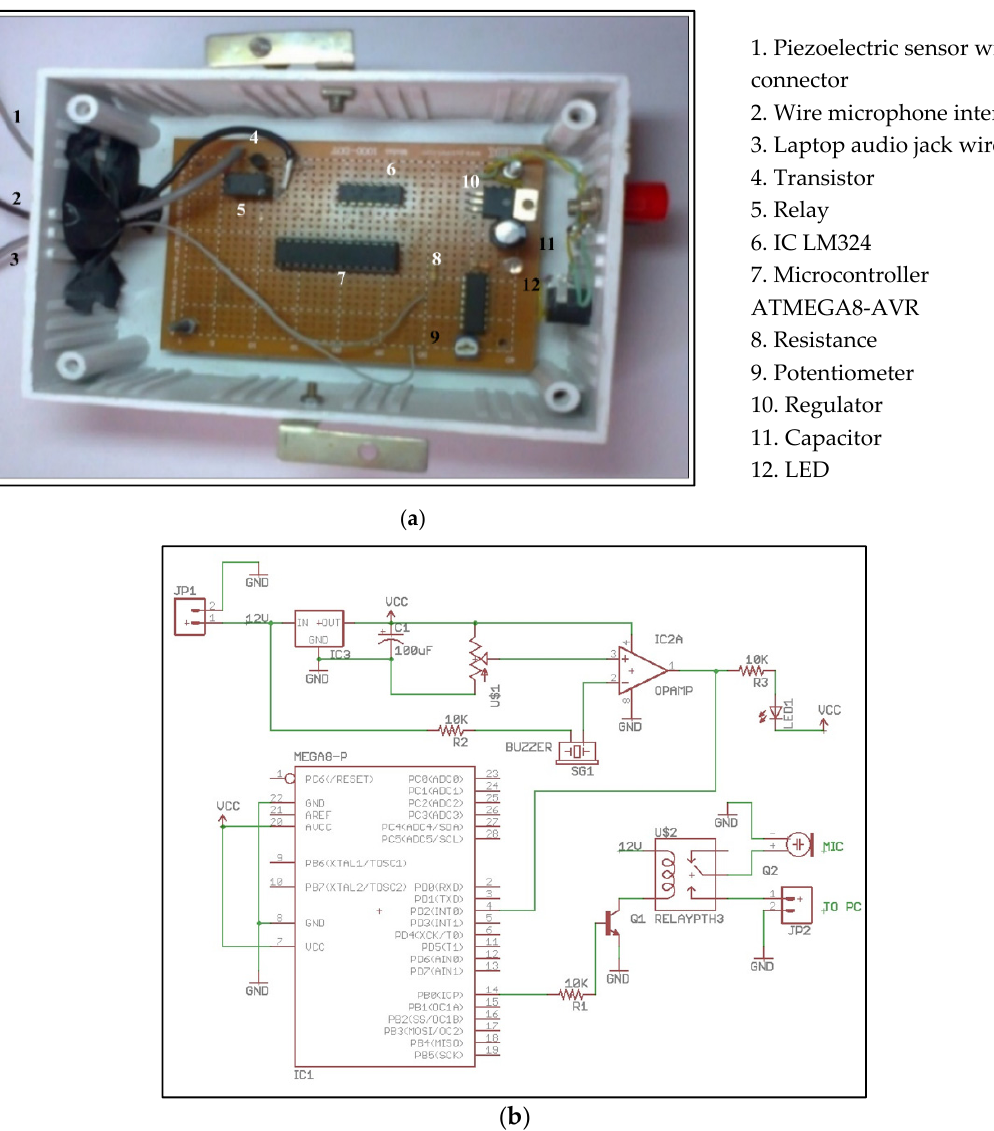
Figure 7. ( a ) The sound collecting circuit and ( b ) the schematic diagram of the circuit.